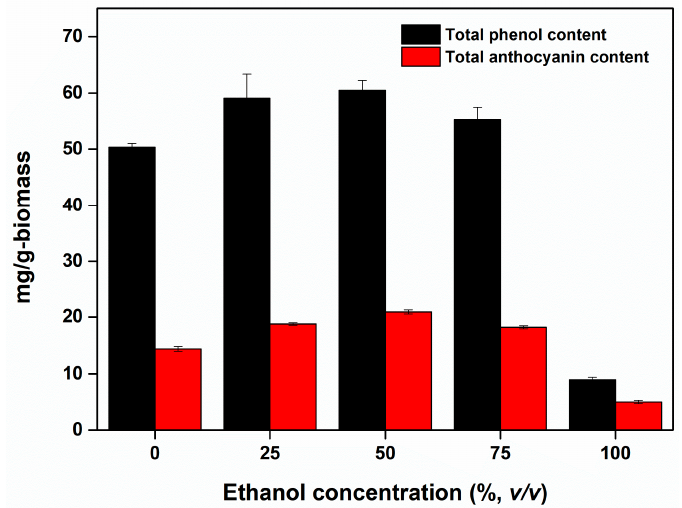
Figure 1. Total phenolic and total anthocyanin content recovered from elderberry for various ethanol concentrations.